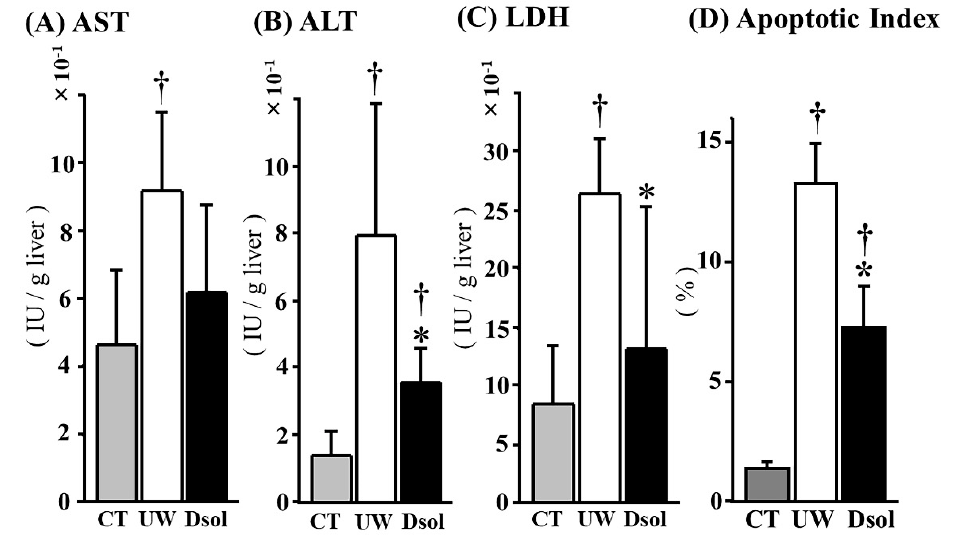
Figure 2. Dsol ameliorates liver enzymes leakage and apoptotic index. Liver enzymes leakage in the perfusate during 90 min of reperfusion was evaluated and expressed as IU / g liver. In the CT group, the AST, ALT, and LDH activities were the lowest. In the UW group, they were significantly augmented, whereas the elevation of ALT and LDH was significantly suppressed in the Dsol group, and AST in the Dsol group was lower than that of UW group, but not statistically significant ( A–C ). Apoptotic index was the lowest in the CT group. In the UW group, it was significantly augmented, whereas the elevation of apoptosis was significantly suppressed in the Dsol group ( D ). Data were expressed as the means ± SD ( n = 6). * † A p -Value less than 0.05 was considered significant: *: UW versus Dsol, † versus